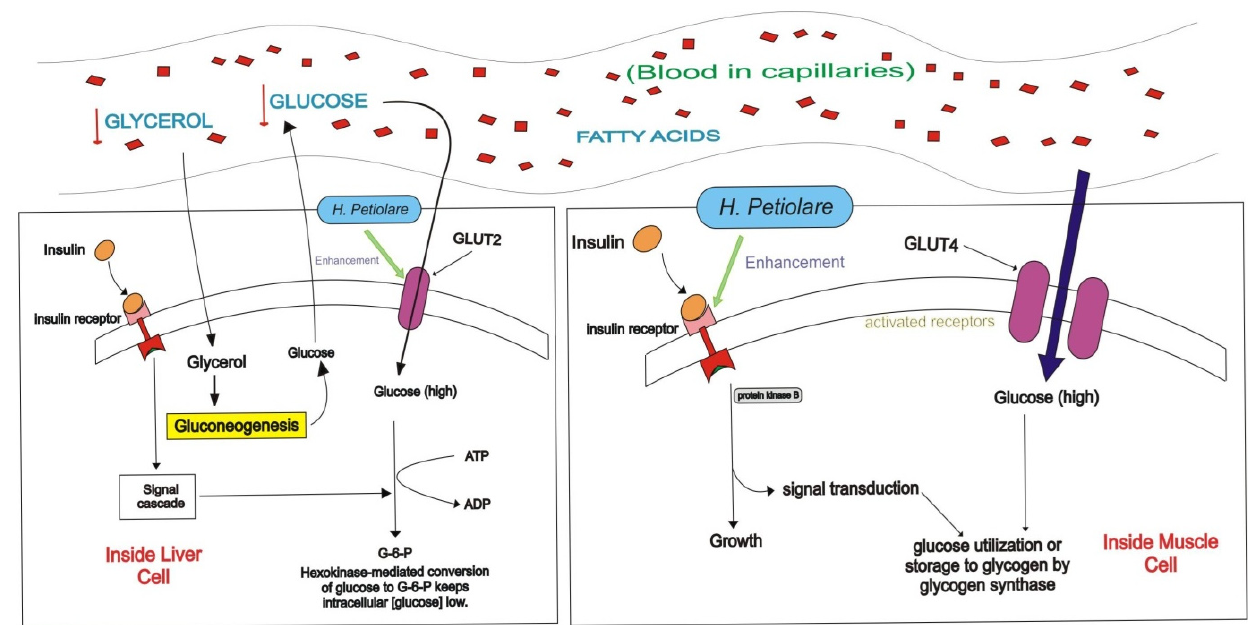
Figure 6. Summary of the proposed effects of H. petiolare on glucose uptake in the hepatocytes and myocytes of a human subject. The figure shows the levels of glucose uptake after treatment with H. petiolare . “ ↓ ” indicates decrease.